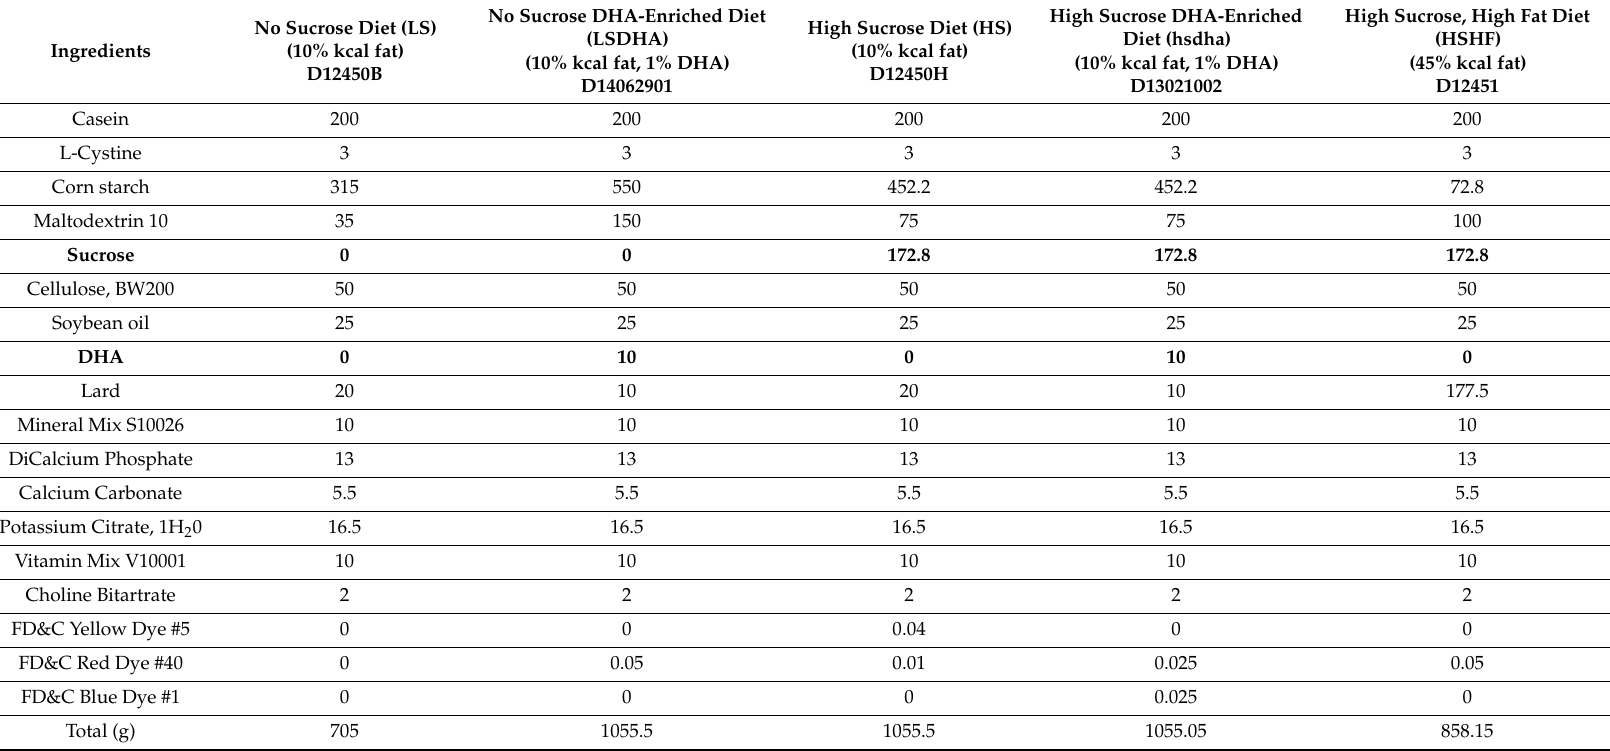
Table 1. Composition of diets. Ingredients presented as gram of total